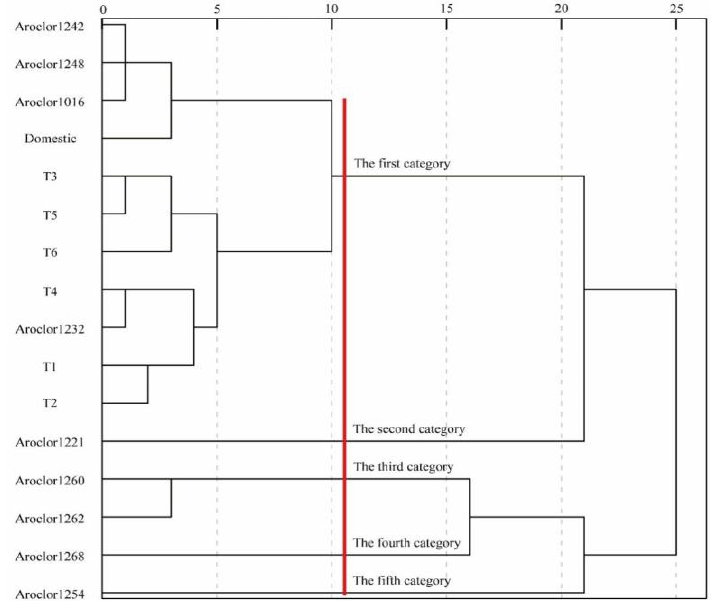
Figure 5. Hierarchial dendogram for soil samples in Tumochuan irrigation area, Aroclor PCBs and Chinese transformer oil.